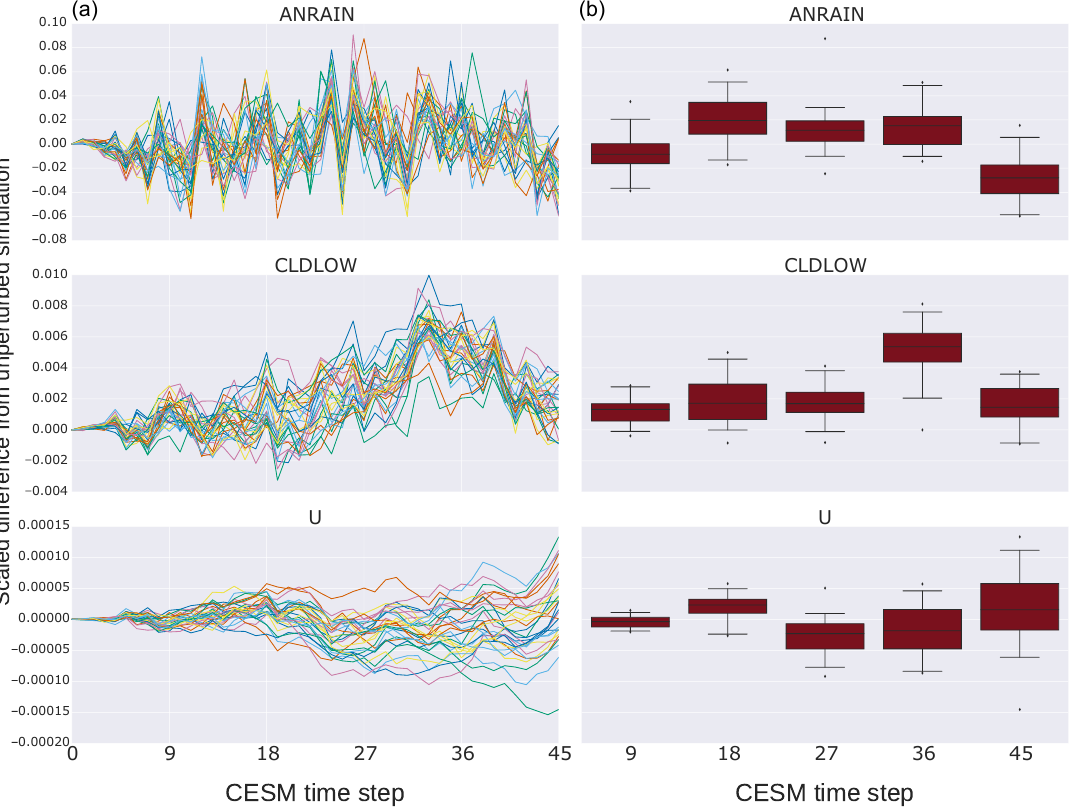
Figure 2. The vertical axis labels the difference between the unperturbed simulation and the perturbed simulations’ area weighted global means, divided by the unperturbed simulation’s area weighted global mean for the indicated variable at each time step. The horizontal axis is the CESM time step with intervals chosen as multiples of nine. The left column (a) plots are time series representations of the values of three CAM variables chosen as representatives of the entire set (variables behave similarly to one of these three). The right column (b) plots are statistical representations of the 30 values plotted at each vertical grid line of the corresponding left column. More directly, each box plot depicts the distribution of values of each variable for each time step from 9 to 45 in multiples of 9.